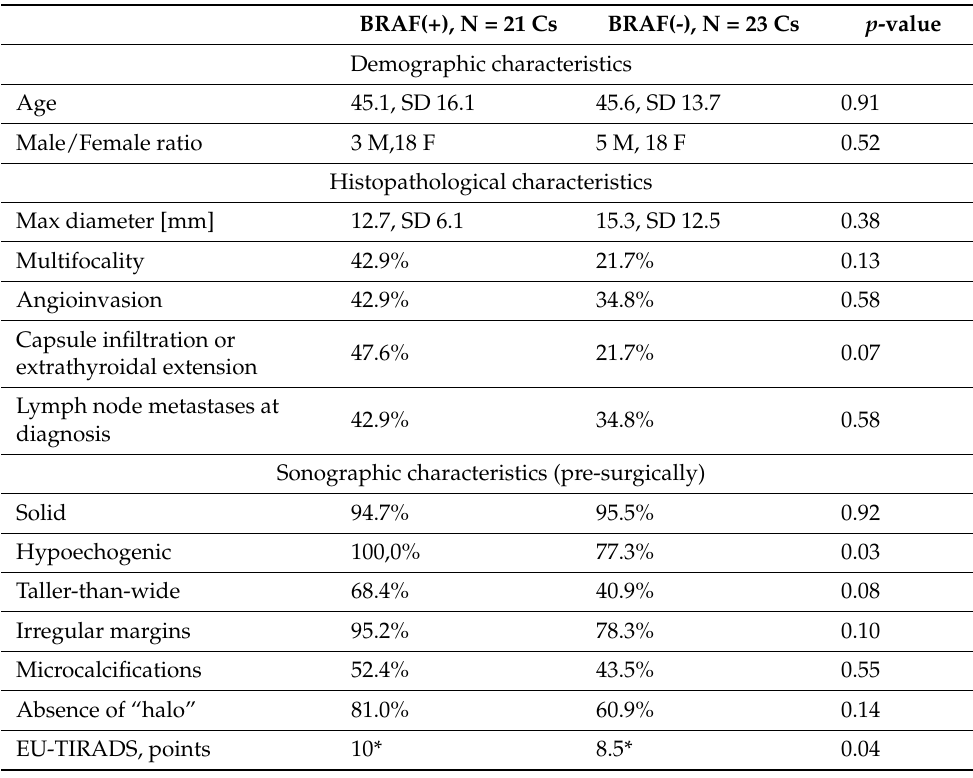
Table 1. Main characteristics of BRAF V600E positive and BRAF V600E negative patients’ groups.